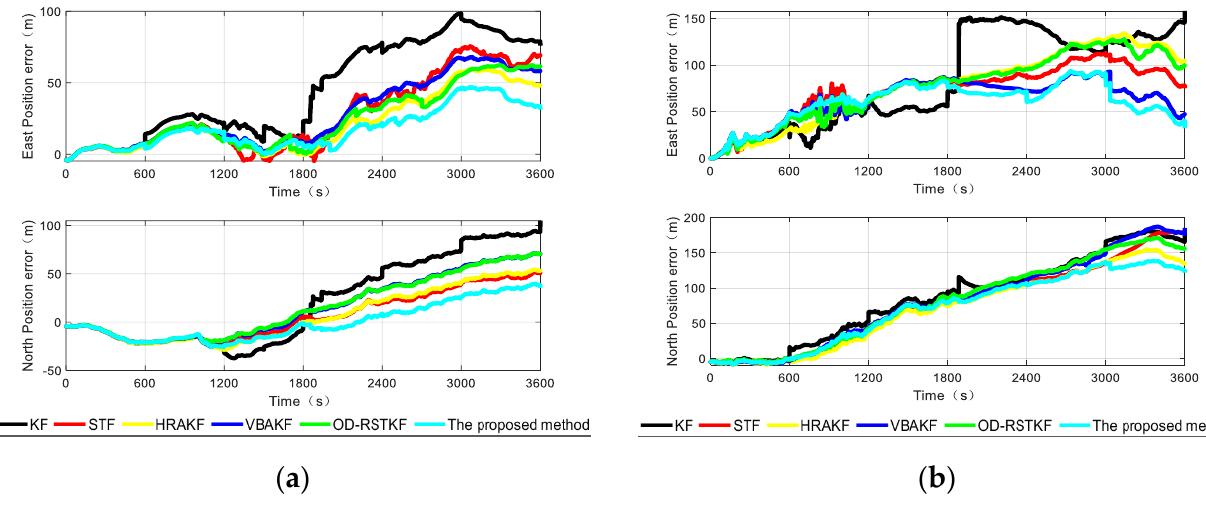
Figure 13. The position errors from different algorithms in two segments ( a ) The position error of different algorithms in the first test; ( b ) The position error of different algorithms in the second test.